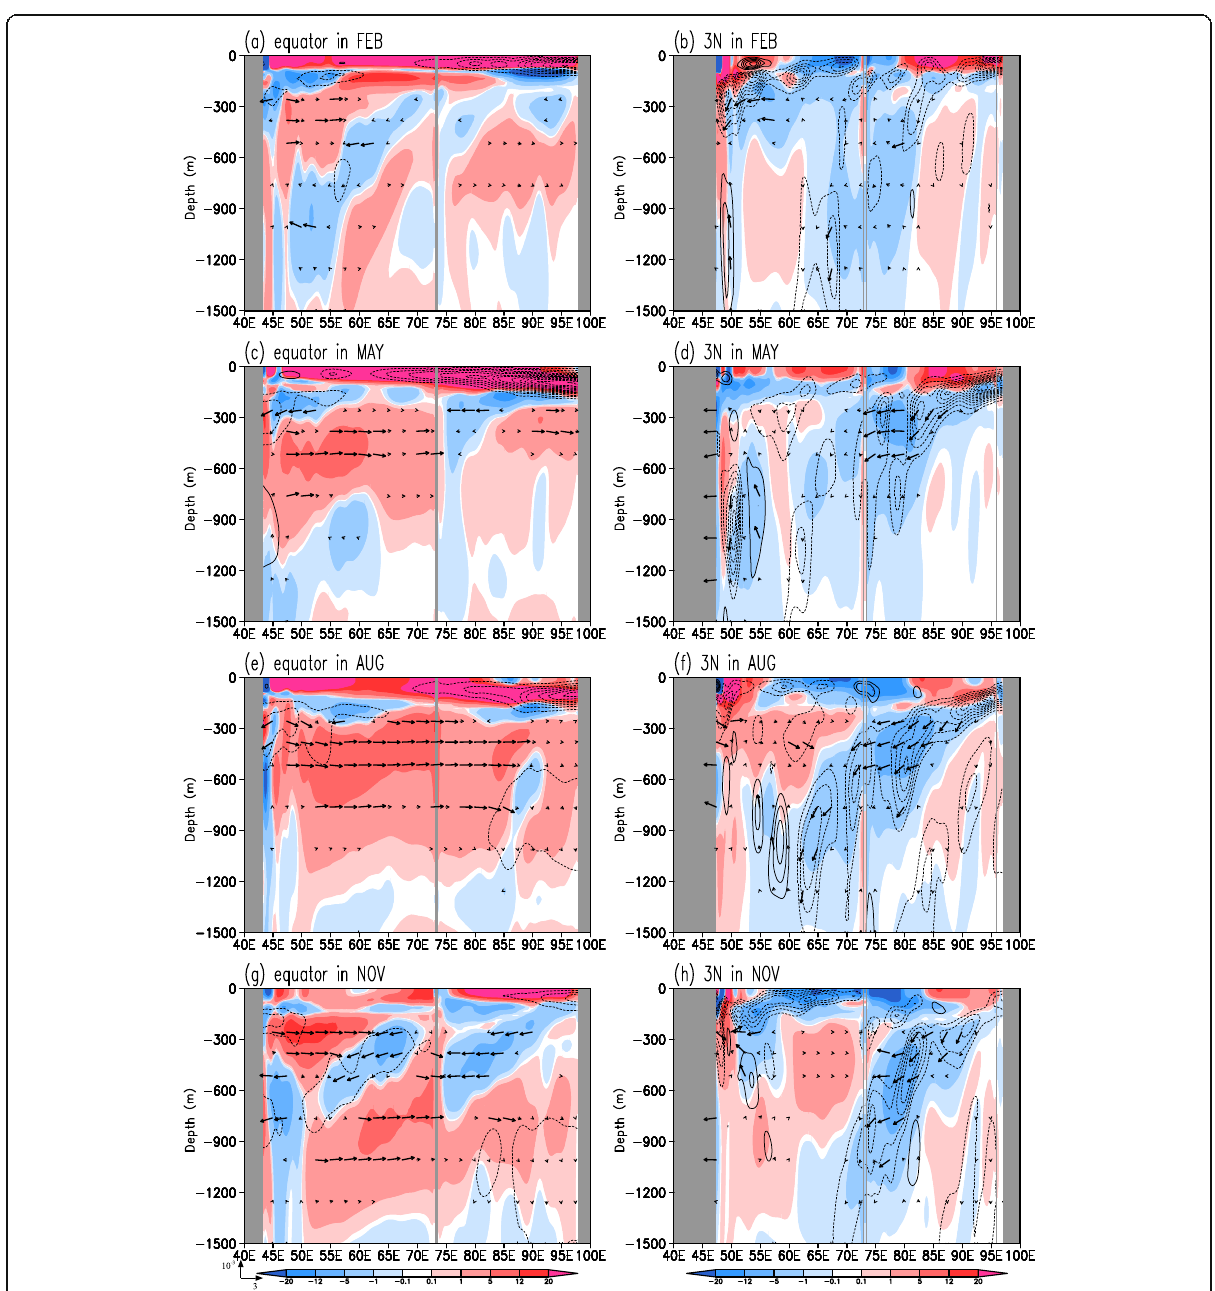
Fig. 8 Zonal-vertical sections at the equator (left) and at 3° N (right) from “ Year 20 ” of our climatological model experiments: a , b mid-February, c , d mid-May, e , f mid-August, and g , h mid-November. The zonal component of the energy flux (color shaded in units of W/m 2 ), the vertical component of the energy flux (solid contours for positive values, dotted contours for negative values; with an interval of 4 ×10 − 4 W/m 2 ) and the energy flux vector (arrows in units of W/m 2 ) estimated from the depth-dependent version of the Aiki, Greatbatch, and Claus Level-2 scheme, as given by (7b). When under 3 W/m 2 , the magnitude of energy flux is indicated either by arrow length or, for greater values, by heavy arrows of uniform